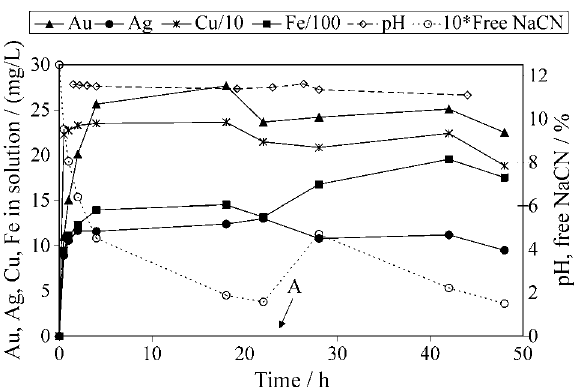
Figure 4. Product cyanidation using 1.25% NaCN solution; 1 kg of product, 2 L of solution, 54 g of lime; 20 g NaCN were added to the pulp at time A. Au recovery = 64.3%.